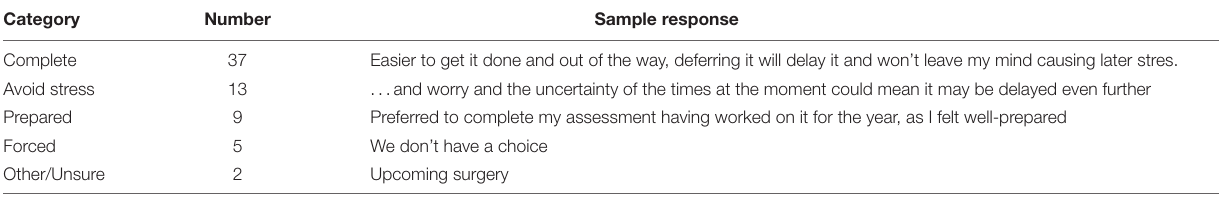
TABLE 5 | Reasons provided for students choosing to submit their assessment by the originally published deadline*. Category Sample response